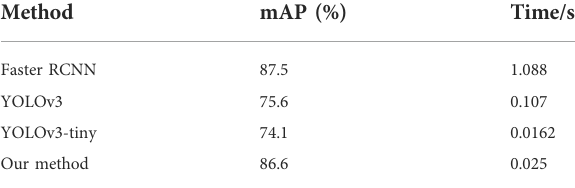
TABLE 5 Results of contract